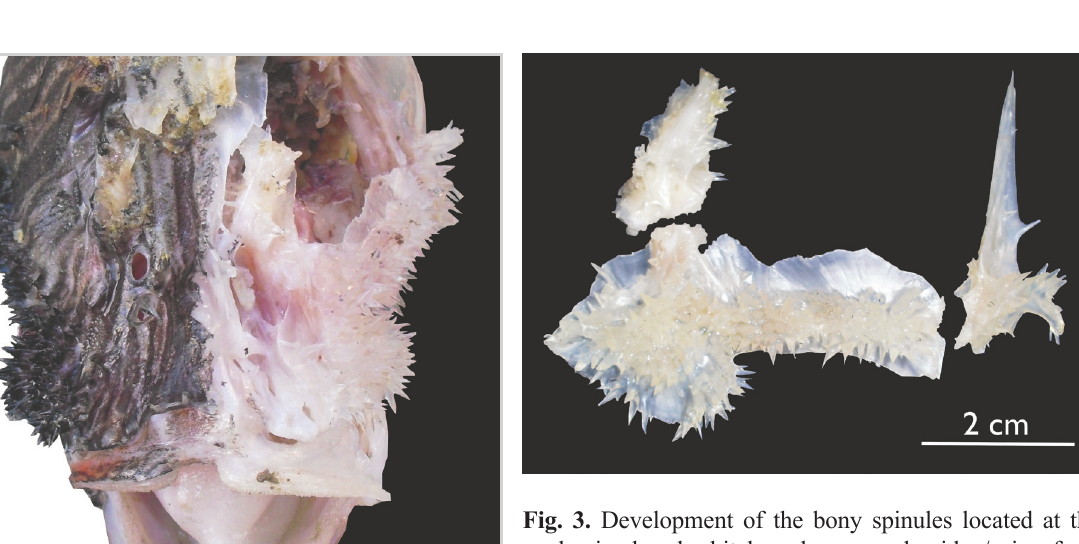
Fig. 3. Development of the bony spinules located at the lacrimal, suborbital, and preopercle ridge/spine from the head bones (the lacrimal and suborbital), may have at least three fused bones referred to in literature as first, second, and third infraorbital